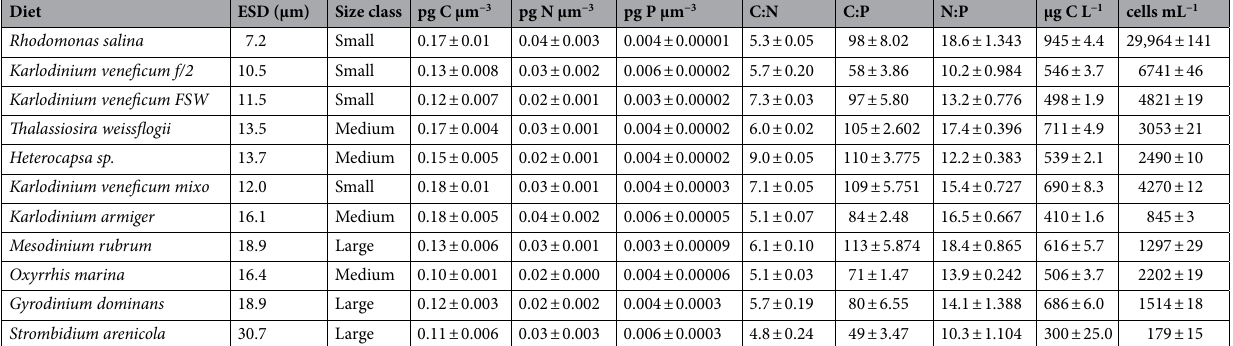
Table 1. Size (equivalent spherical diameter, ESD), size class, elemental content and stoichiometric molar ratios of the prey species. The prey carbon and cell concentrations used in the copepod feeding incubations are also provided. Average ± 1